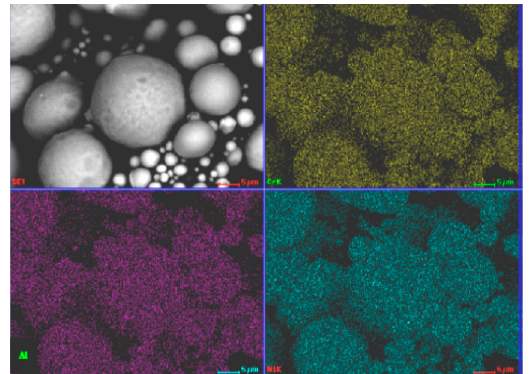
Figure 7. EDS elemental Ni-Cr-Al mapping of powder particles.